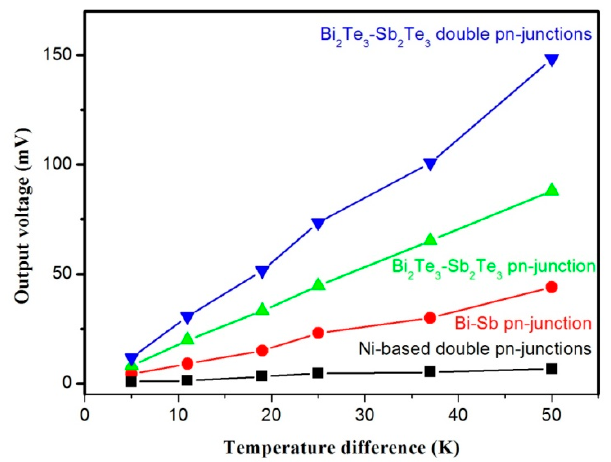
Figure 4. The open output voltage of the TFTED with various materials as function of temperature difference. Table 2. The room-temperature thermoelectric properties of the thin films. Seebeck Coefficient Electrical Conductivity